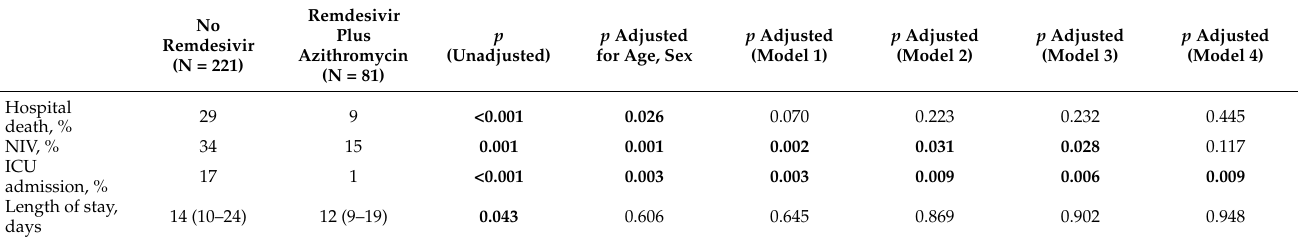
Table 4. Comparison of study outcomes between patients who received remdesivir azithromycin during hospital stay and those who did not receive